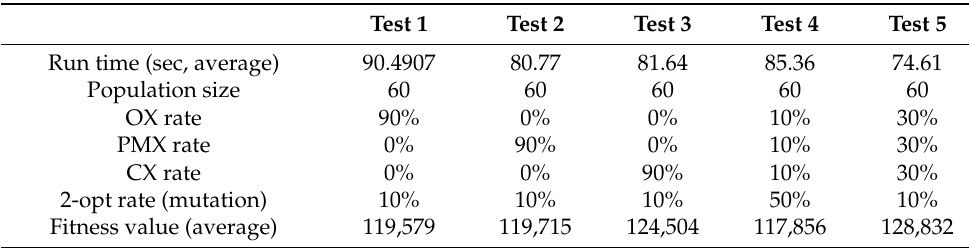
Table 7. Real optimization run with Genetic